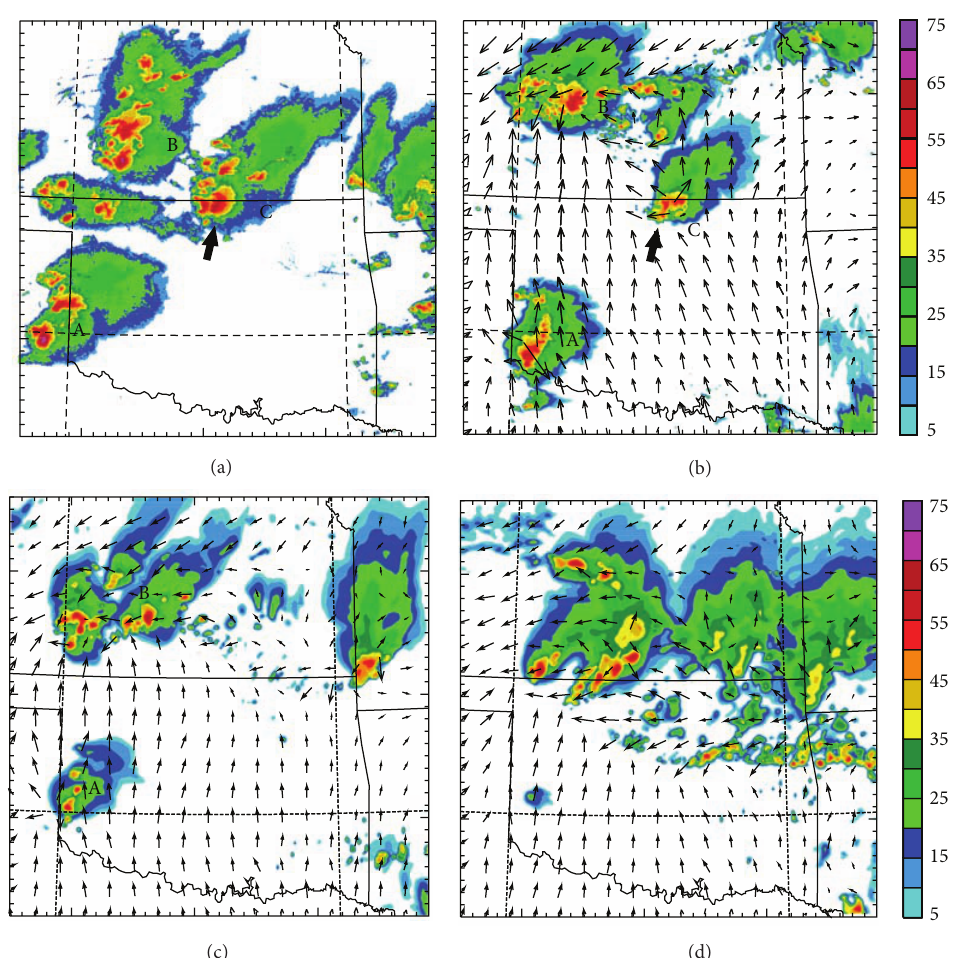
Figure 3: As Figure 1 but valid at 2300 UTC, 26 May 2008, corresponding to 23-hour forecast time and for a zoomed-in subdomain. The bold arrow near “C” points to the supercell discussed in the text.